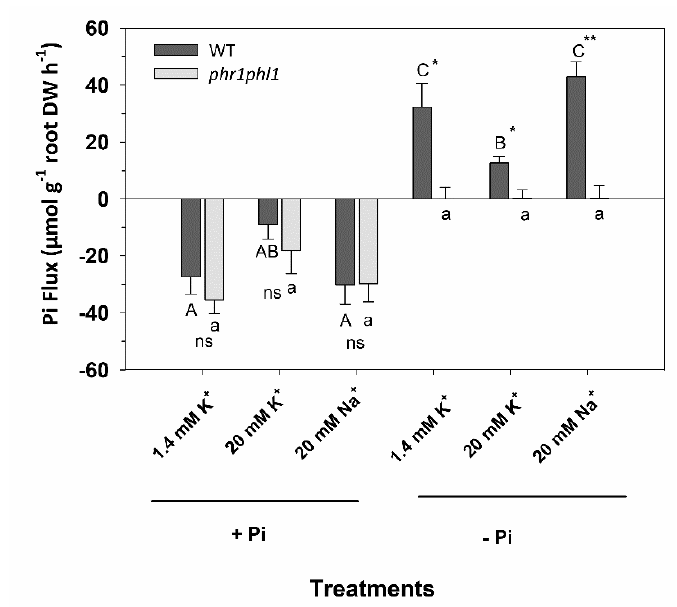
Figure 4. Pi fluxes in Pi-sufficient and Pi-starved plants from a 30 µM external Pi in the absence or the presence of 1.4 mM KCl, 10 mM KCl or NaCl. Plants of WT (dark grey bars) and phr1phl1 mutant (light grey bars) were grown for 33 days in a control 1/5 Hoagland solution containing 0.2 mM Pi and then transferred for 7 days to the same solution (+Pi) or a solution without Pi ( − Pi). Then, plants were incubated for 8 h in nutrient solution with 30 µM Pi in the absence or in the presence of 10 mM KCl or 10 mM NaCl. Samples of this external solution were taken at different time points to determine their Pi concentration. Flux rates of Pi were calculated from the variation in external Pi per h and per g of root dry weight. Shown are average Pi fluxes of three repetitions and errors bars denoted standard error. ANOVA was used to study the effects of the treatment (T), the genotype (G), and their interaction (TxG) resulting in: (A) T = ***, G = *** and TxG = *. Bars with different letters within lines denote significant differences according to Tukey test (uppercase letters for WT and lowercase letters for phr1phl1 line). Differences between genotypes within the same treatment were analyzed according to ANOVA., **, * indicate significant differences at p < 0.01 and 0.05 respectively, n.s. indicates non- significant at p > 0.05.